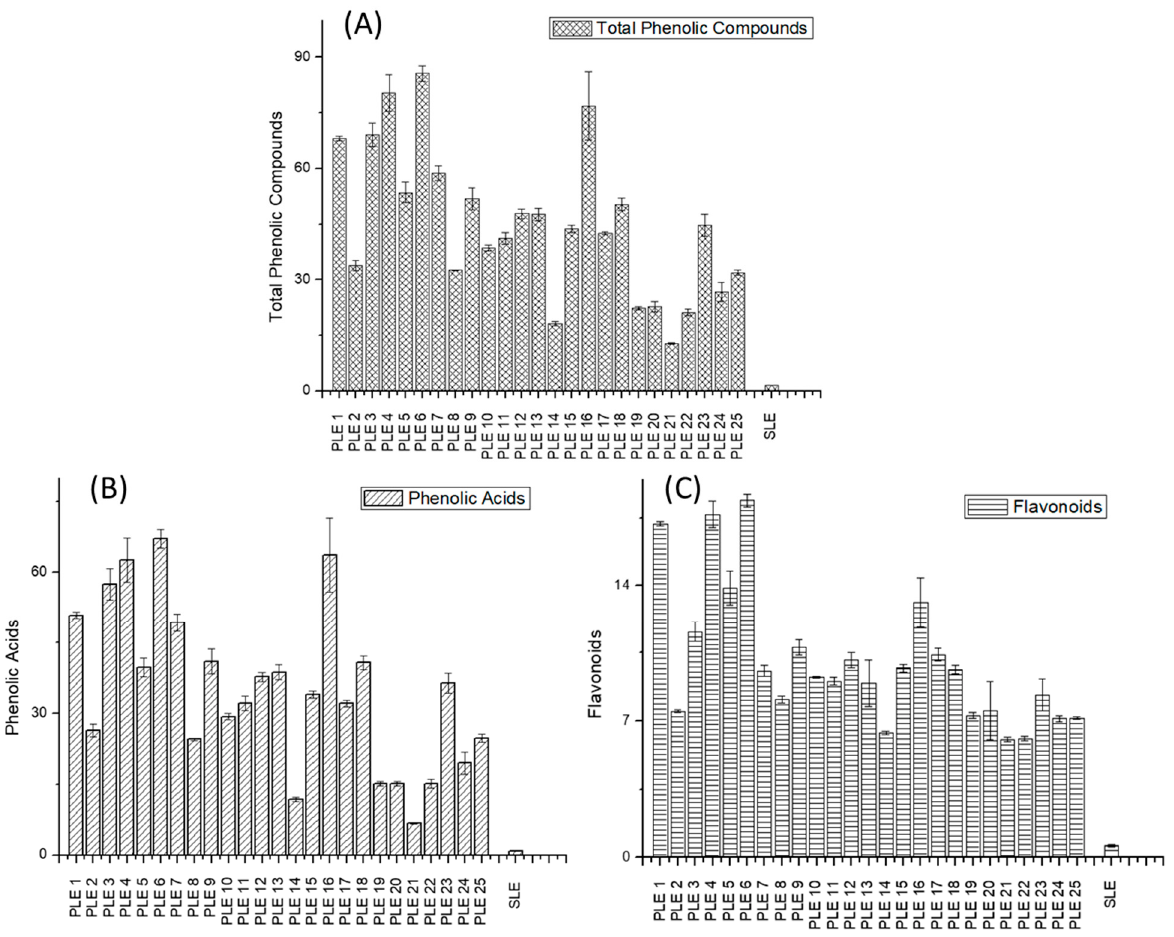
Figure 2. Total content of phenolic compounds ( A ), phenolic acids ( B ), and flavonoids ( C ) of the PLE and SLE extracts. Values expressed in mg compounds/g extract as X ± SD.